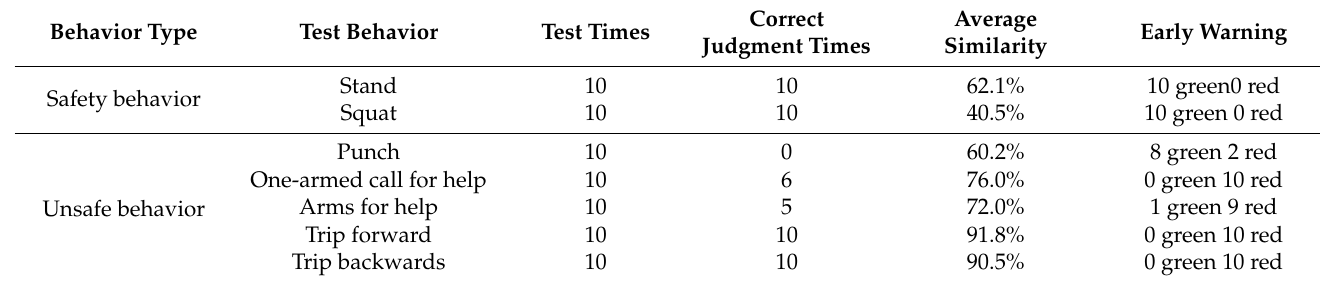
Table 12. Test results using traditional identification